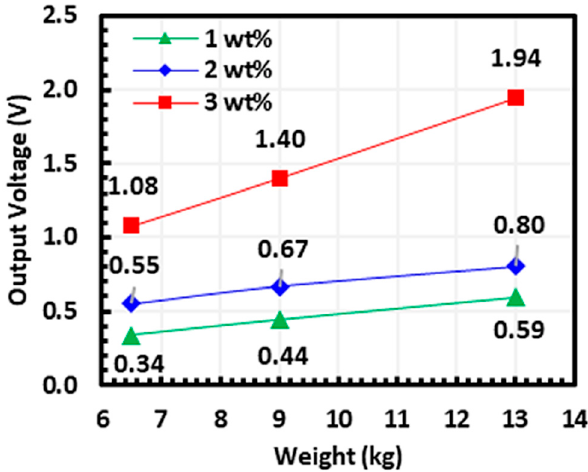
Figure 7. Maximum output voltage (V) of the FWPG with various proportions of WS 2 and press- ing conditions.